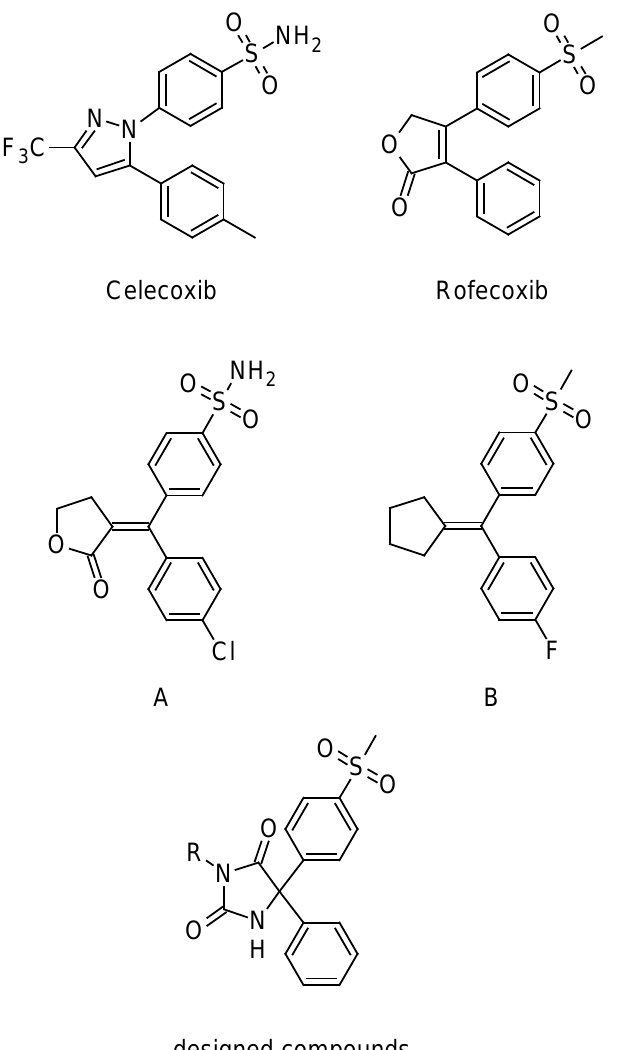
Fig. 1. Some representative examples of selective COX-2 inhibitors and our designed